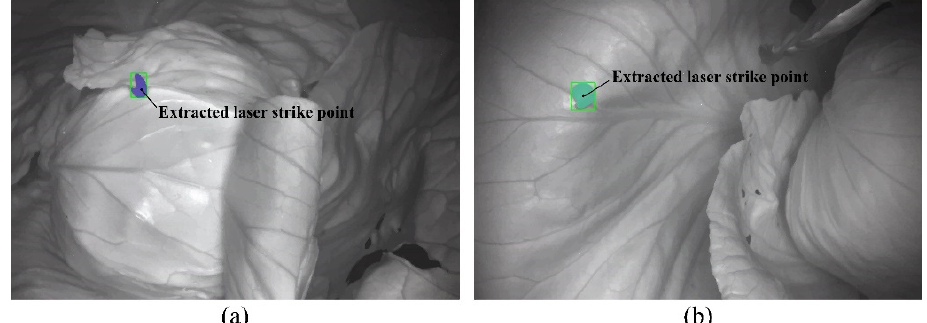
Figure 18. Incorrect location results in special cases. ( a ) The body of the P. rapae shaded by leaves. ( b ) The larvae curl up in a ring.